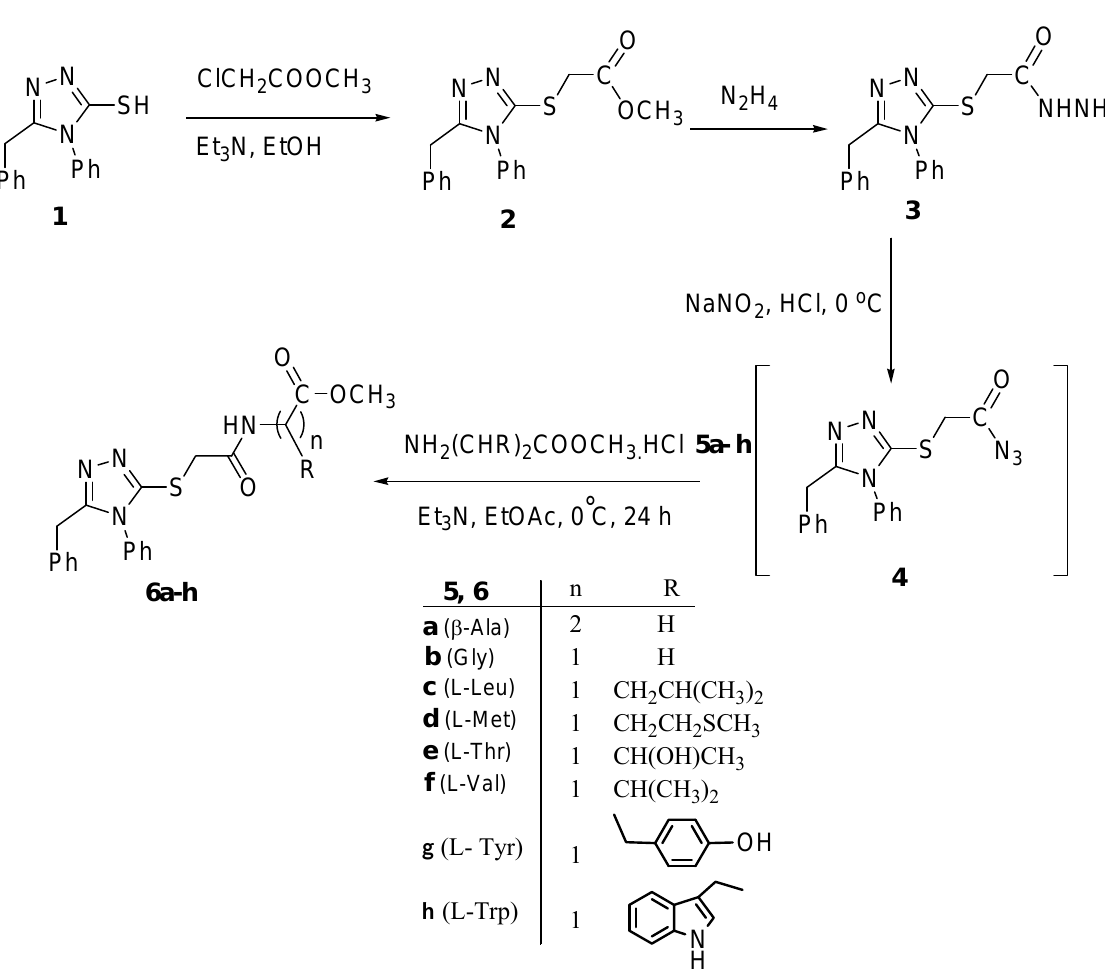
Scheme 1. Synthesis of amino acid monopeptides coupled with